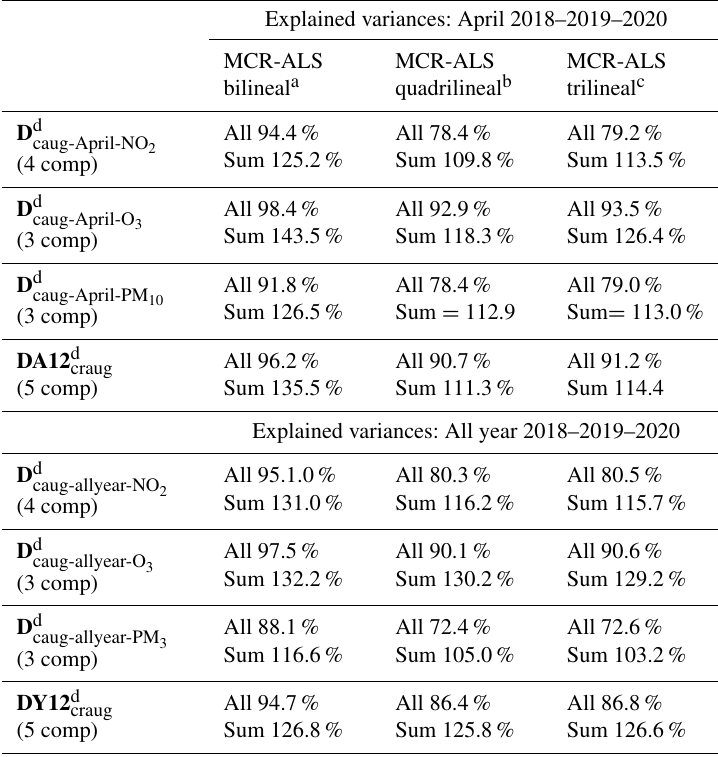
Table 1. MCR-ALS decomposition and explained variances for the different